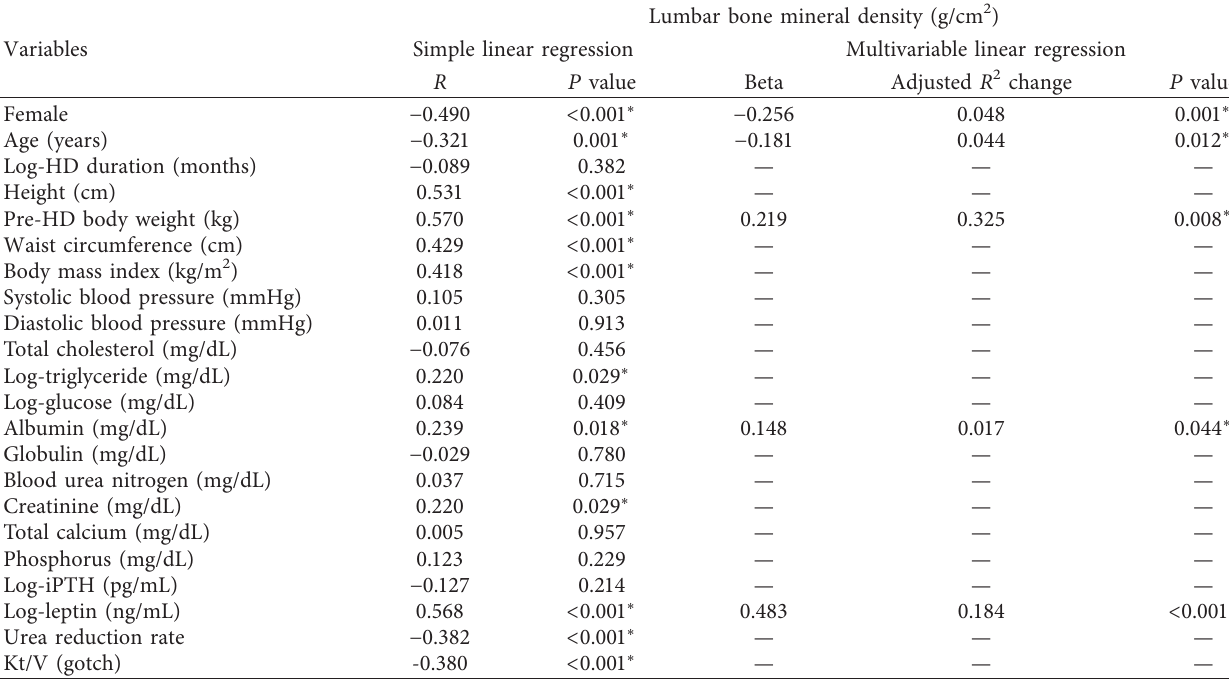
Table 3: Correlation between lumbar bone mineral density levels and clinical variables among hemodialysis patients.